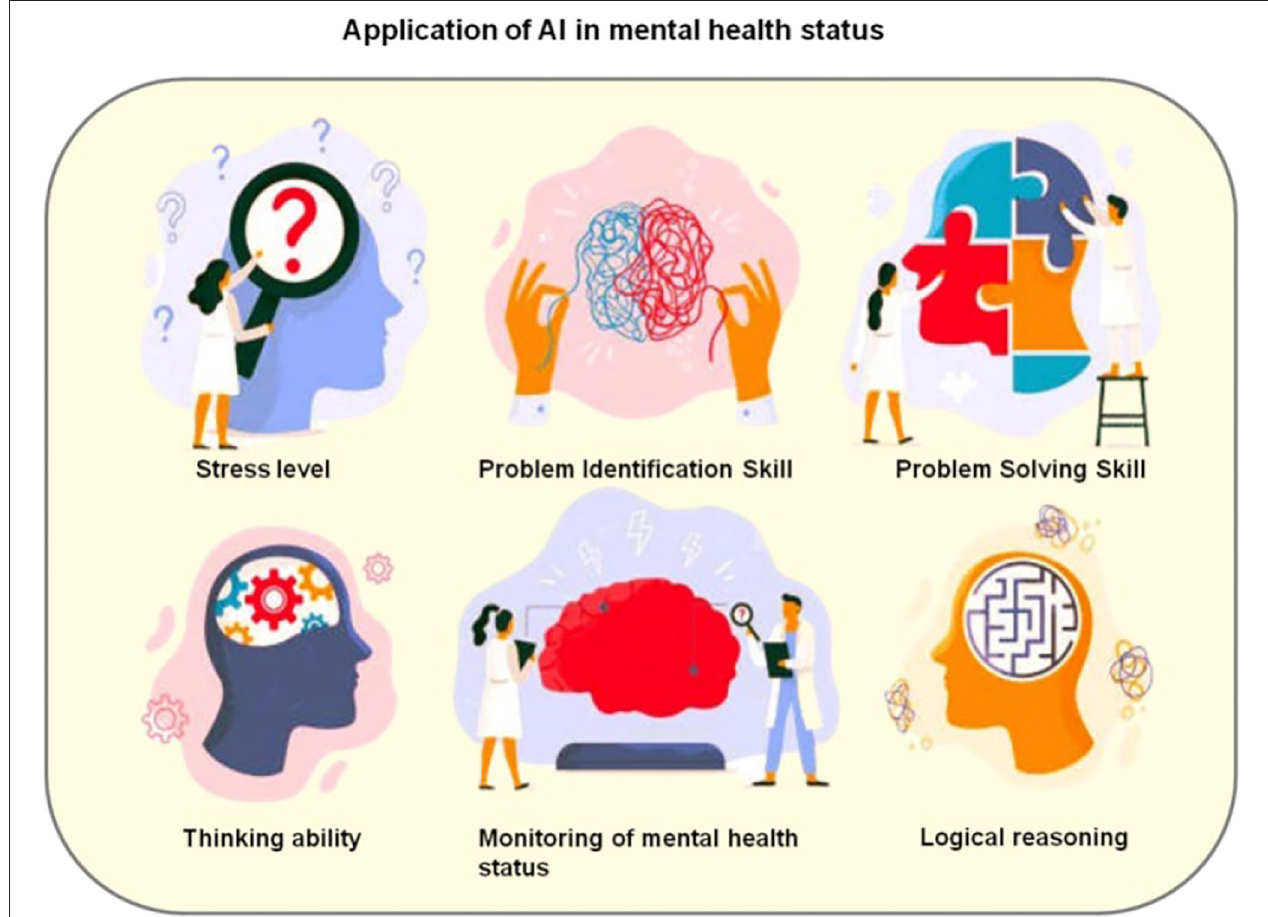
FIGURE 1 | Application of AI in mental health